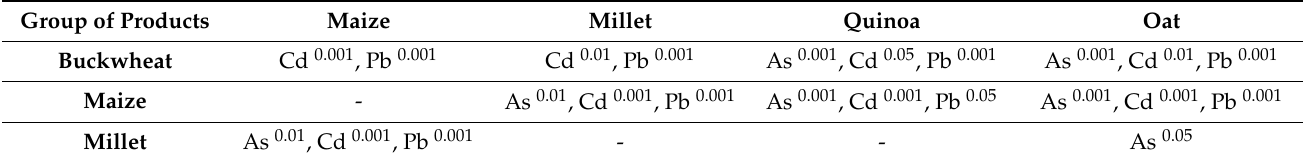
Table 7. Statistically significant differences between the groups of products tested.